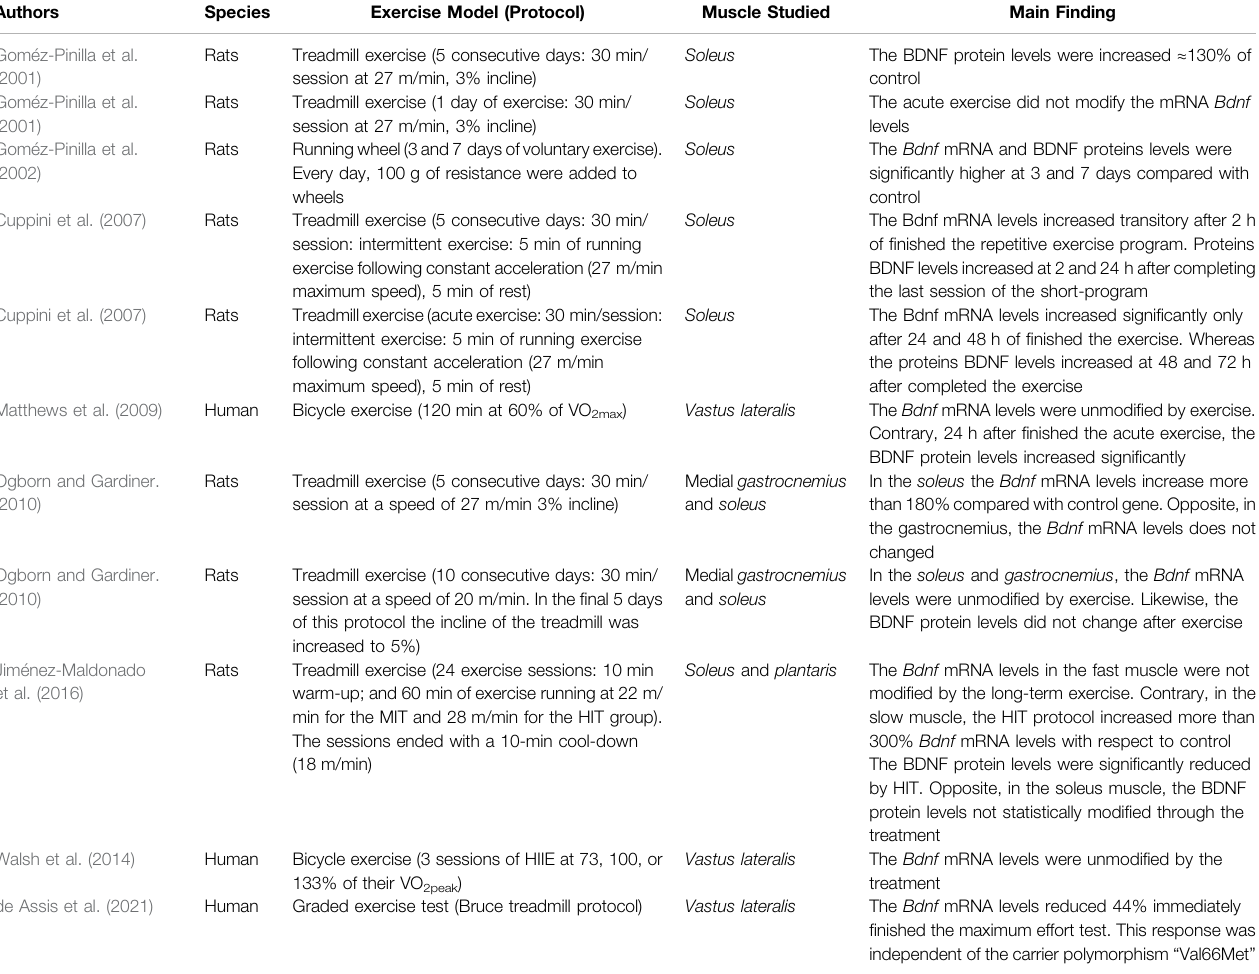
TABLE 1 | Summary of studies on BDNF synthesis in skeletal muscle regulated by the physical exercise. Authors Species Goméz-Pinilla et al. (2001) Goméz-Pinilla et al. (2001)